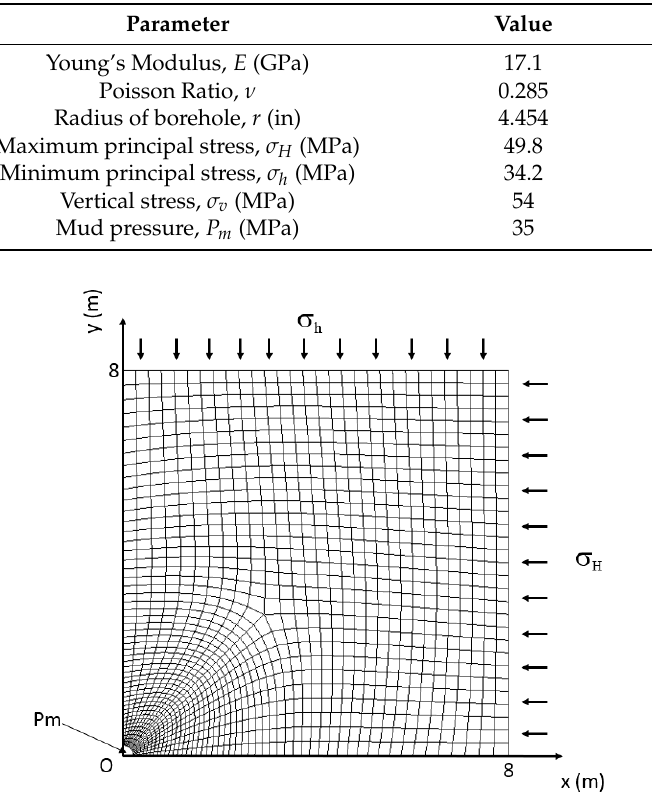
Figure 10. Mesh of the finite element model.